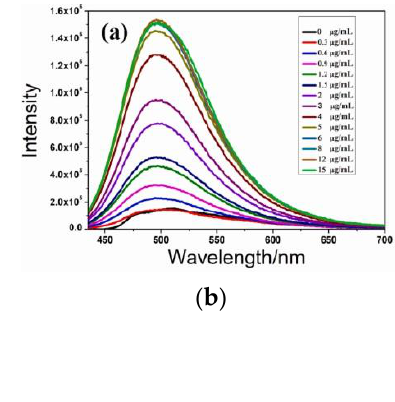
( d ) Figure 9. ( a ) Structure of probe Cy-NO 2 ; ( b ) Fluorescence spectra of Cy-NO 2 ; ( c )Fluorescence im- ages of A549 cells; ( d ) Fluorescence imaging of Cy-NO 2 in normal and tumor-bearing mice. Re- produced with permission from [61]. Copyright 2018 Elsevier B.V.